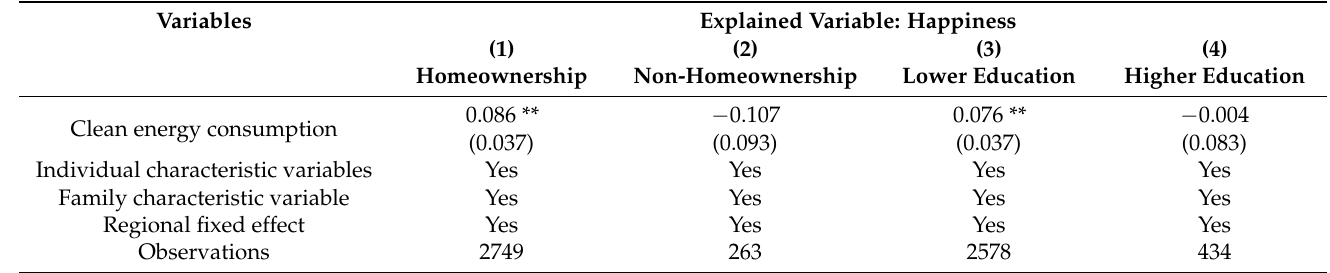
Table 8. Heterogeneity analysis from the perspectives of homeownership and education